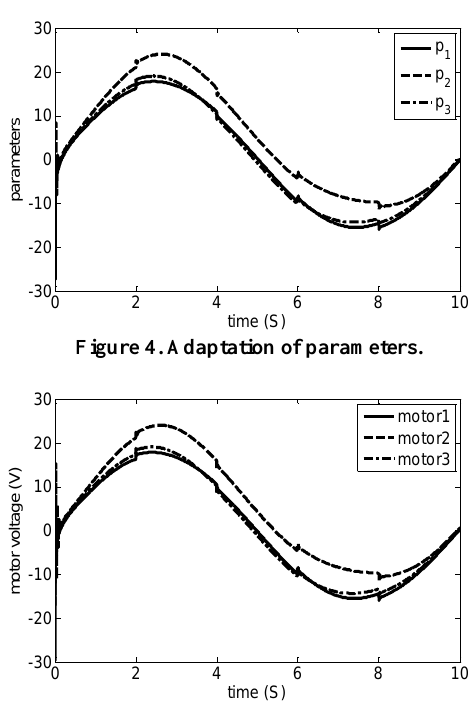
Figure 5. Control efforts of the proposed control.